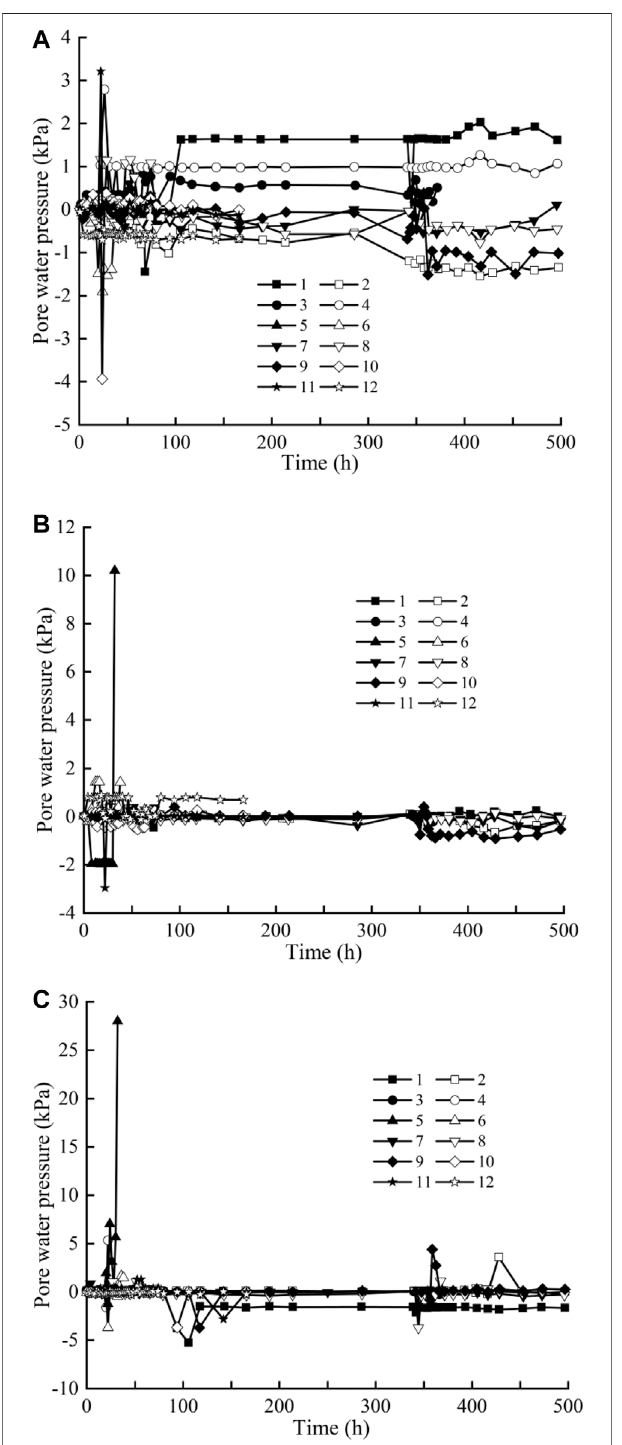
FIGURE 2 | Pore pressure with construction time along the direction of tunnel at different burial depths: (A) 10 m, (B) 13 m, and (C) 16 m. earth pressure within 14 m from the ground surface has a different increase in earth pressure. The increase rate increases with the increase of distance from the ground depth. For the soil